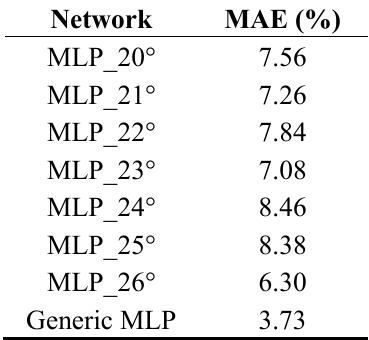
Table 3. The MAEs for different intelligent oil fraction sensors.